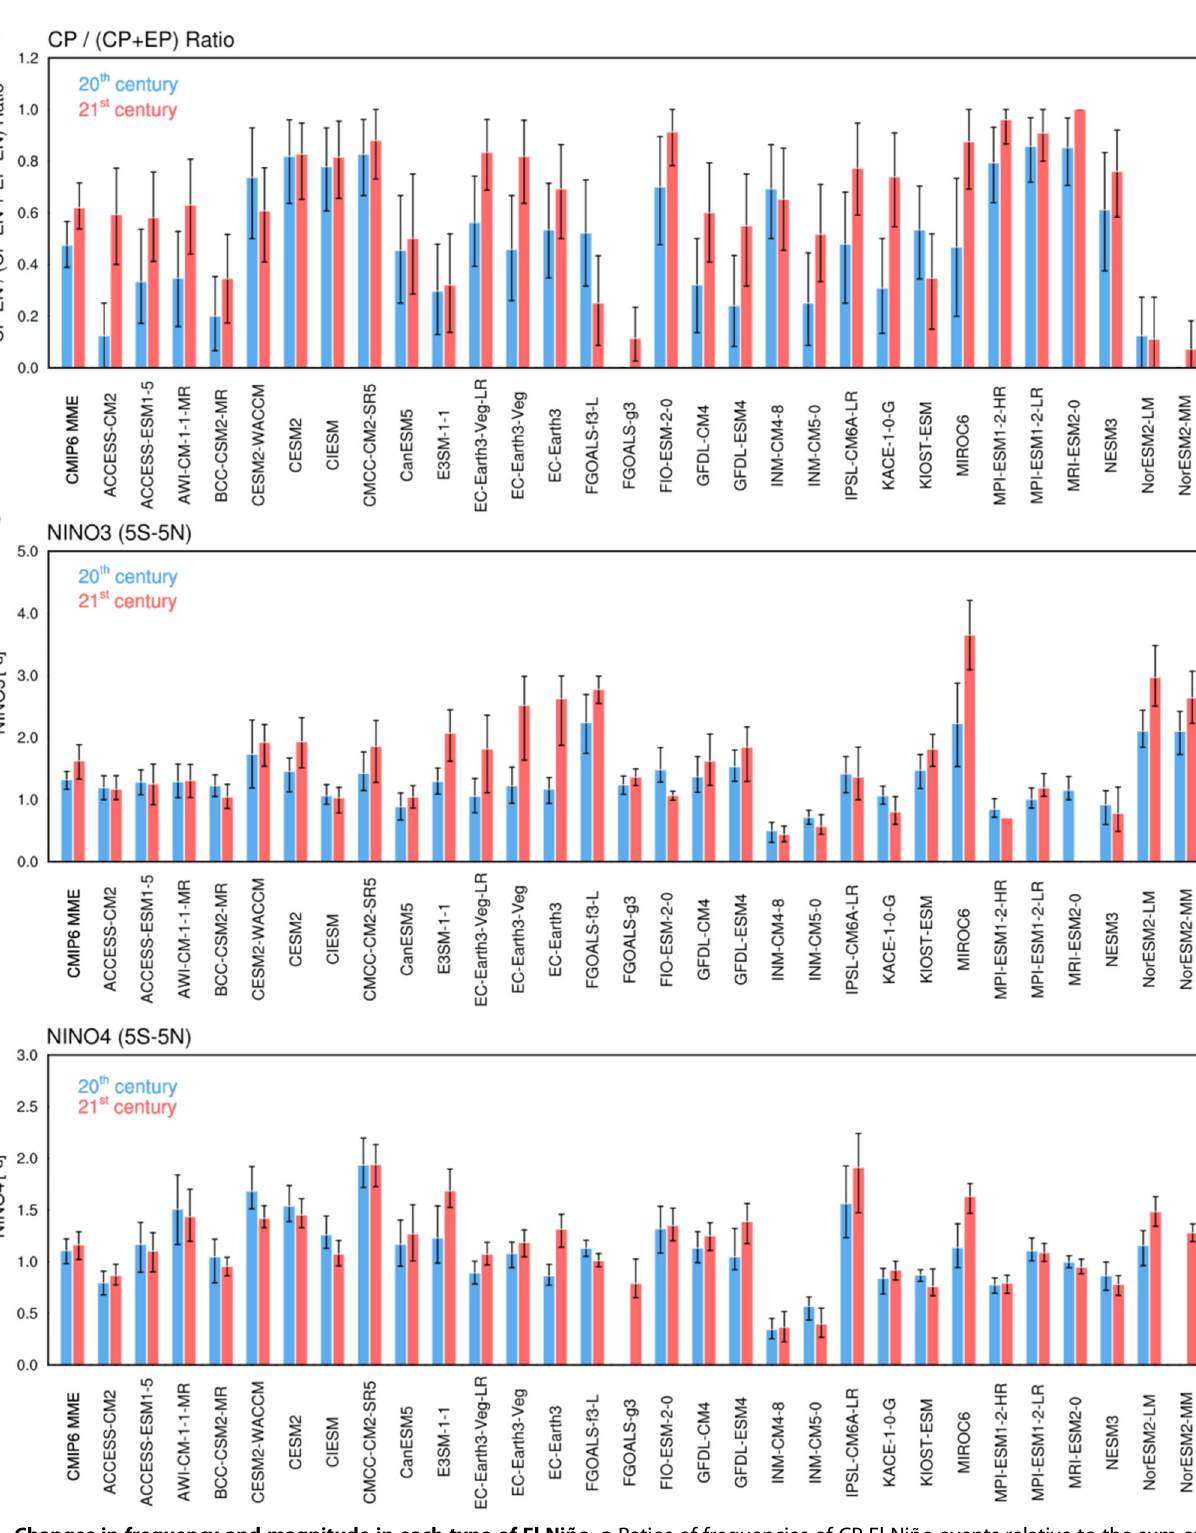
Fig. 2 Changes in frequency and magnitude in each type of El Niño. a Ratios of frequencies of CP El Niño events relative to the sum of the total number of CP and EP El Niño events. b The composites of Niño3 SSTA for EP El Niño events, and c Niño4 SSTA for CP El Niño events. Red and blue bars represent the 20th and 21st centuries, respectively. The error bars indicate the 95% con fi dence level using the bootstrap method (Methods). The units are [°C] for b , c